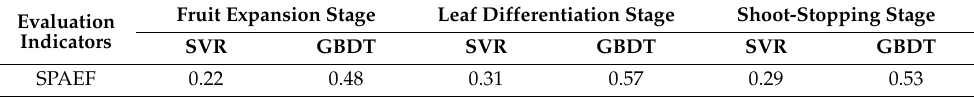
Table 11. Comparison of the SPAEF metric of LAI prediction for the GBDT and SVR models.